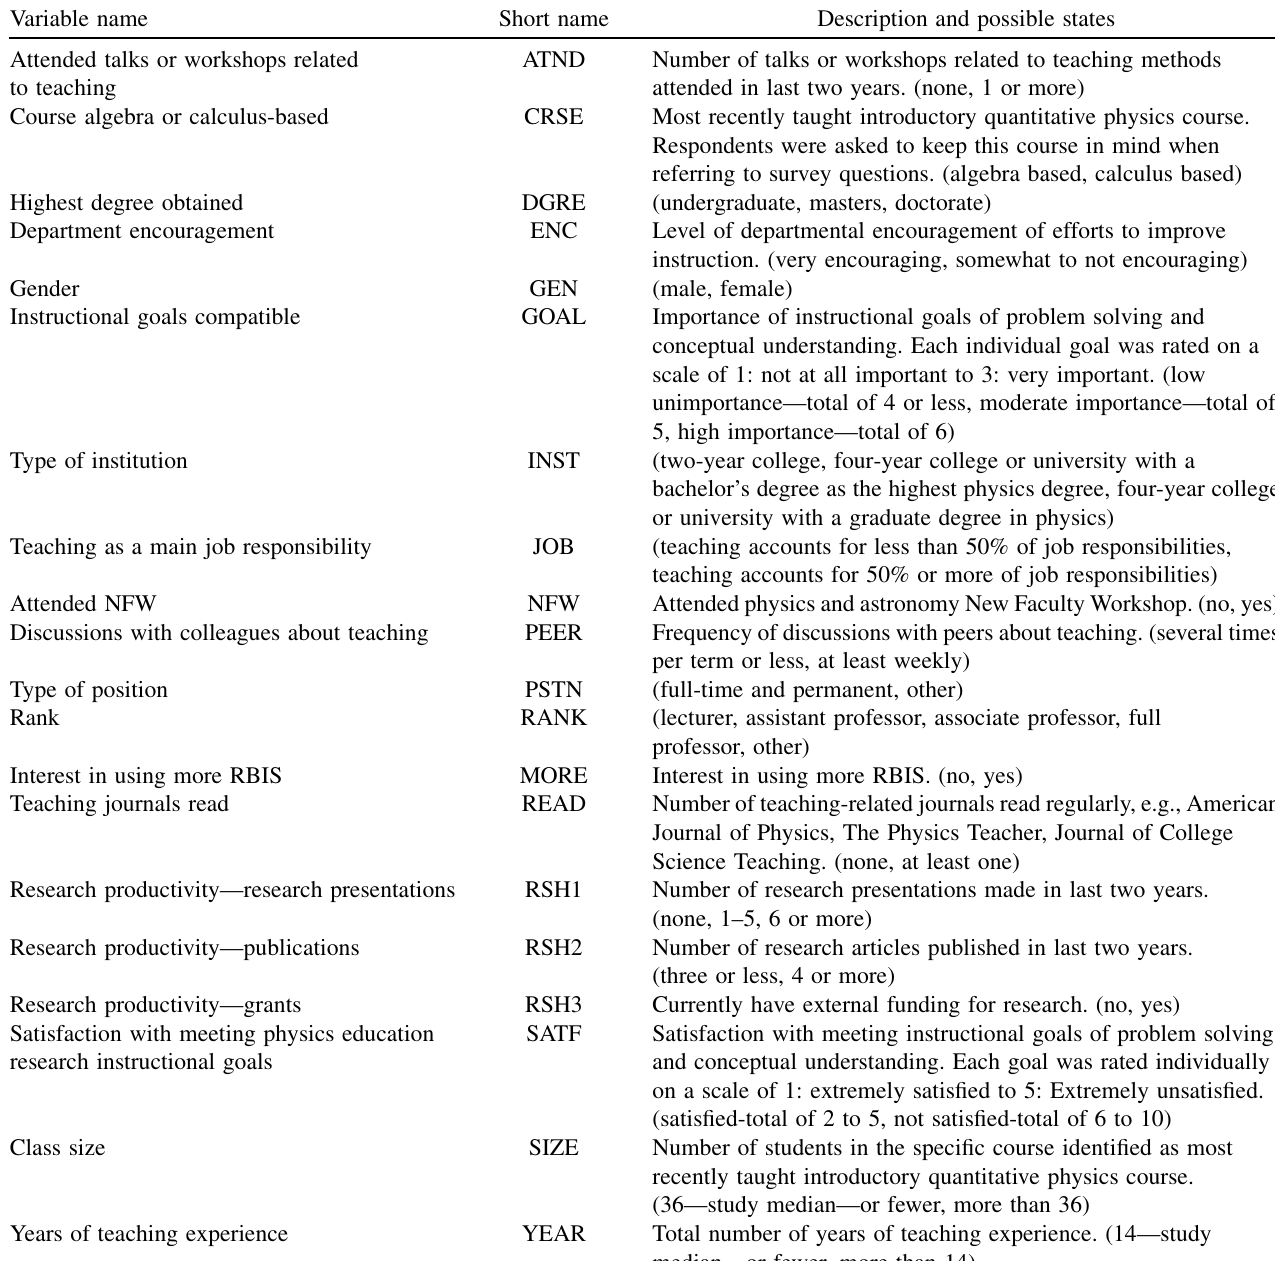
TABLE II. Twenty explanatory variables used in this